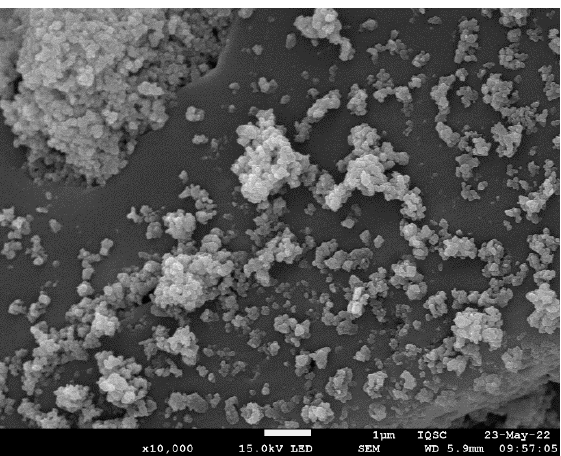
Figure 4. Image obtained by Scanning Electron Microscopy (SEM) of the NiNb catalyst (× 10,000 approximations).